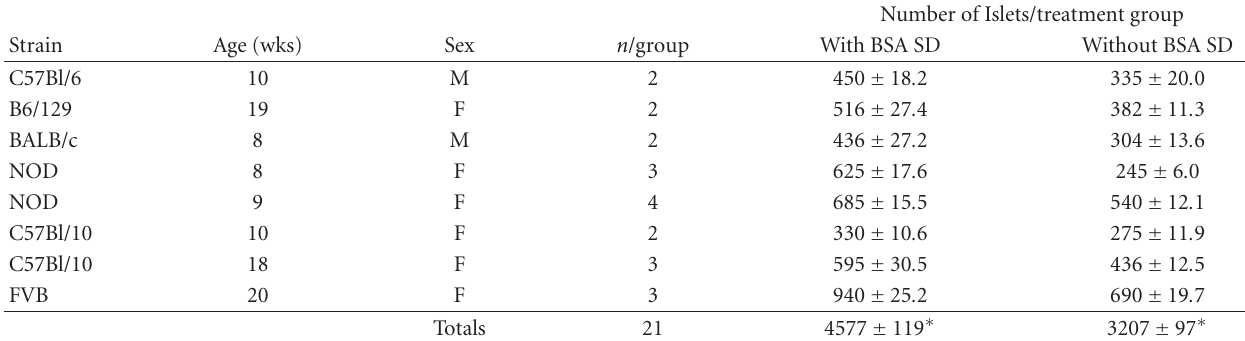
Table 1: Number of islets obtained with and without BSA.